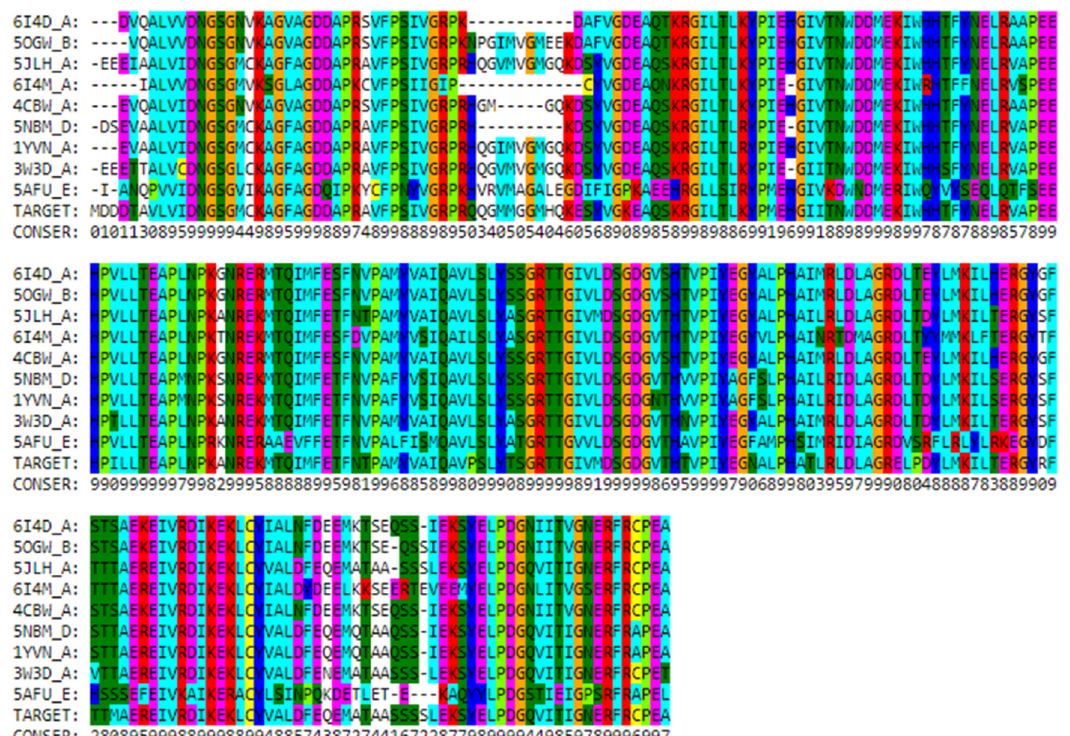
Figure 3: Multiple sequence alignment of the templates selected by DNN for model prediction.